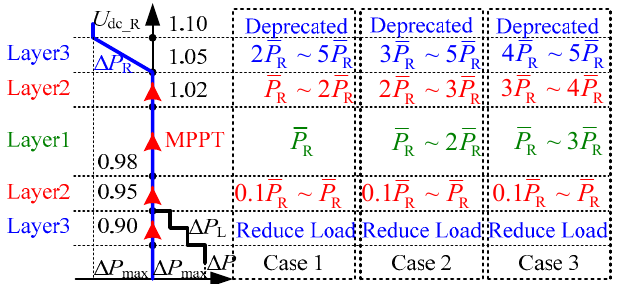
Figure 13. Hierarchical coordinated control strategy.